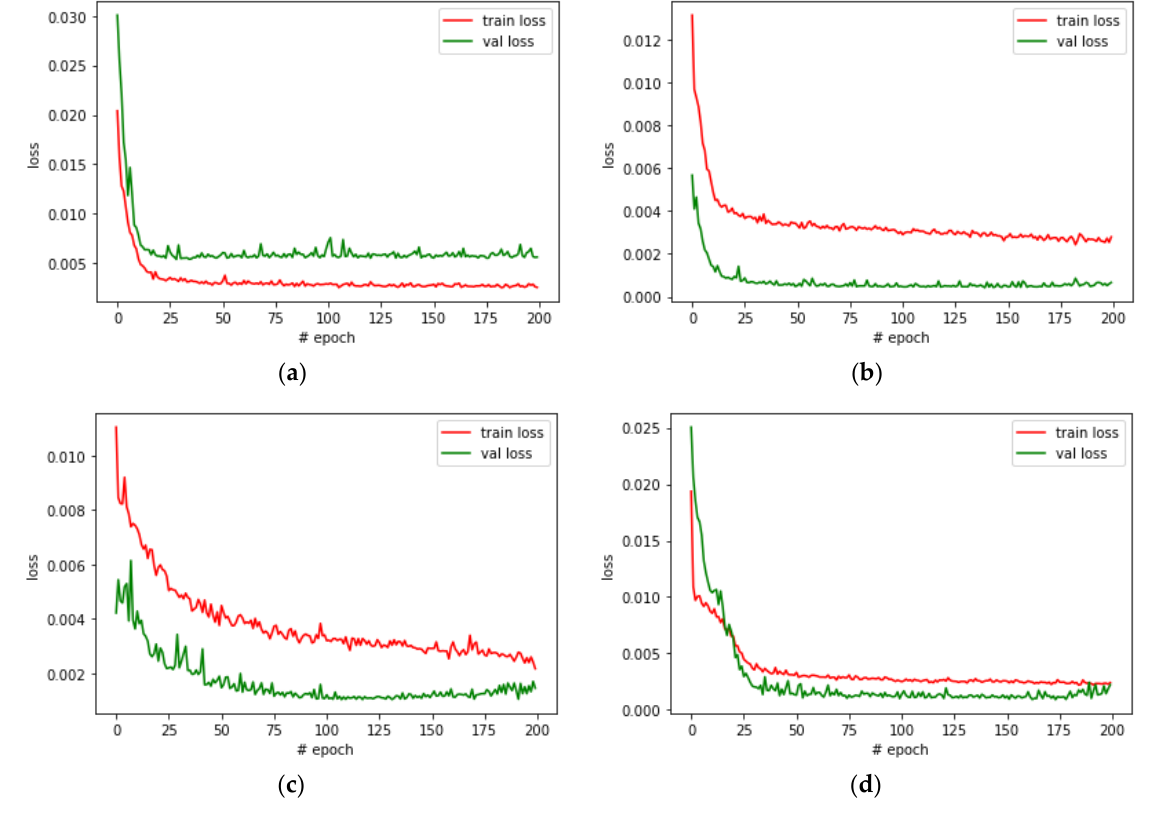
Figure 8. Loss curves of LSTM-based model for ( a ) Kimbulawala, ( b ) Kotte Canal, ( c ) Kotte North, and ( d ) Parliament Lake.